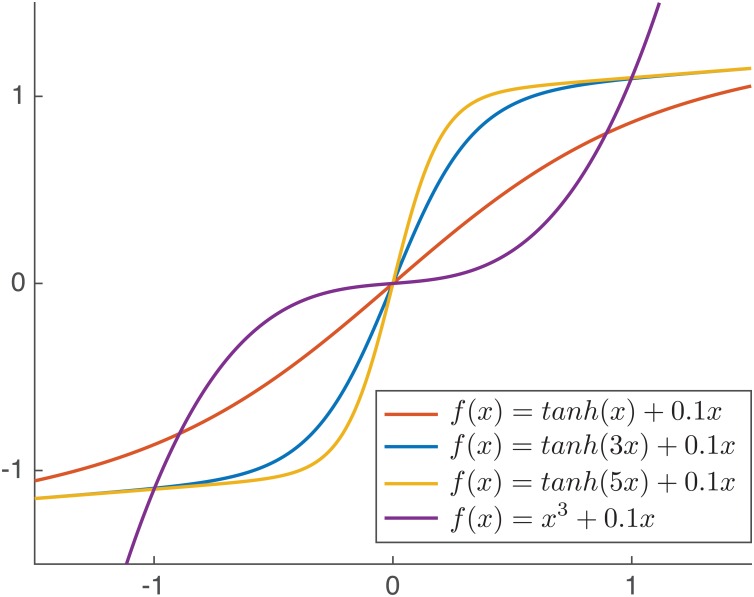
Family of nonlinearities used in the experiments.